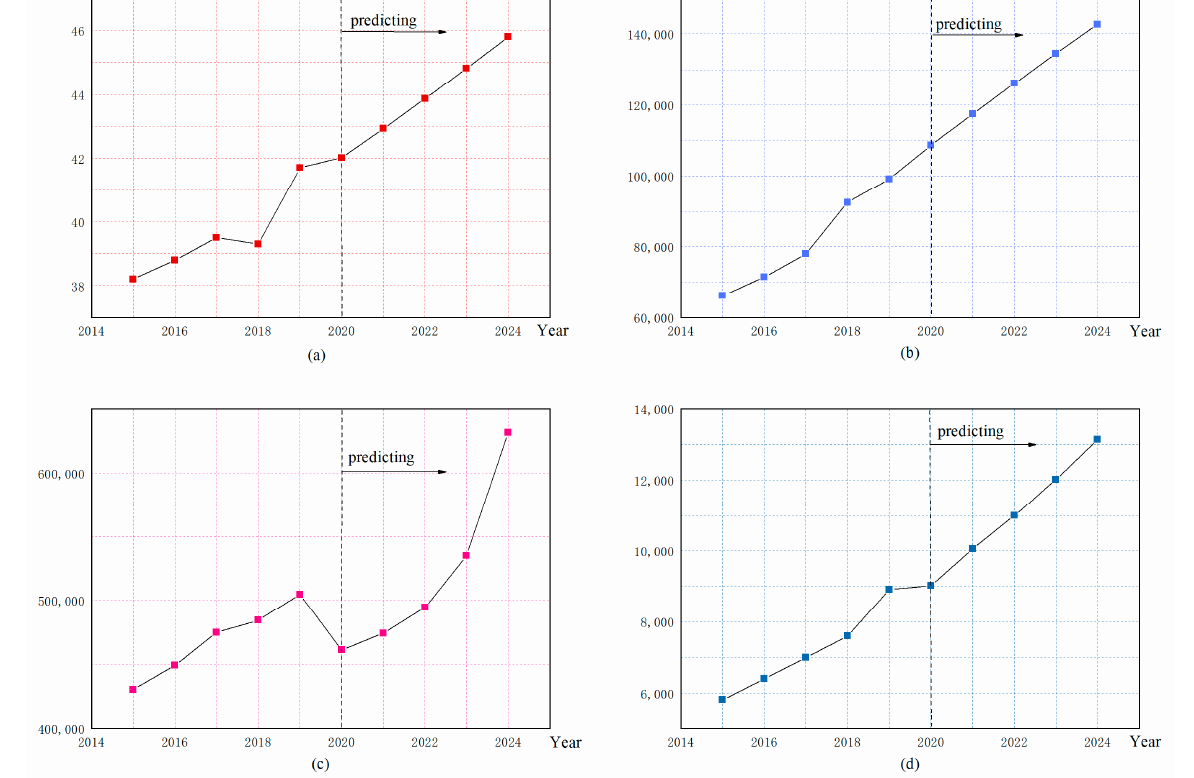
Figure 3. Forecasts of various systems in Beijing ( a ) WR system forecast; ( b ) ES system forecast; ( c ) IS system forecast; ( d ) TI system forecast.